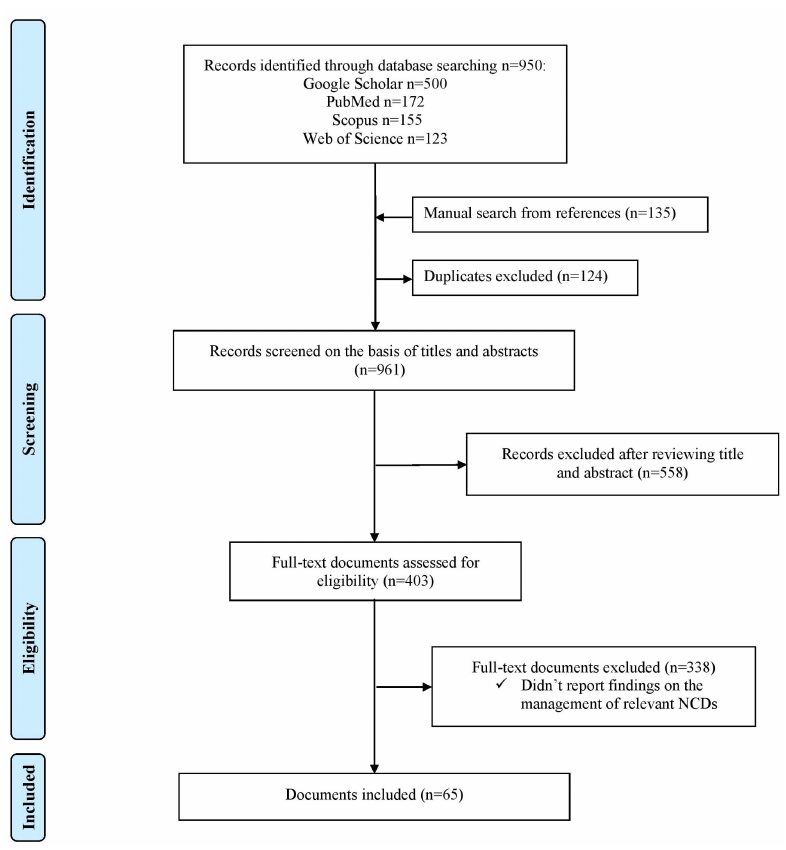
Figure 2. Selection of